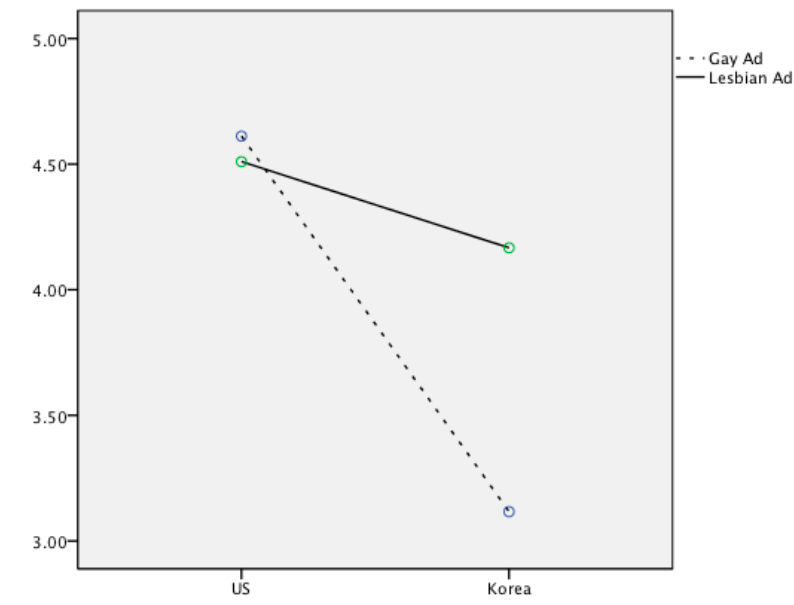
Figure 1. Interaction between cultural orientation and ad type on advertising evaluation.